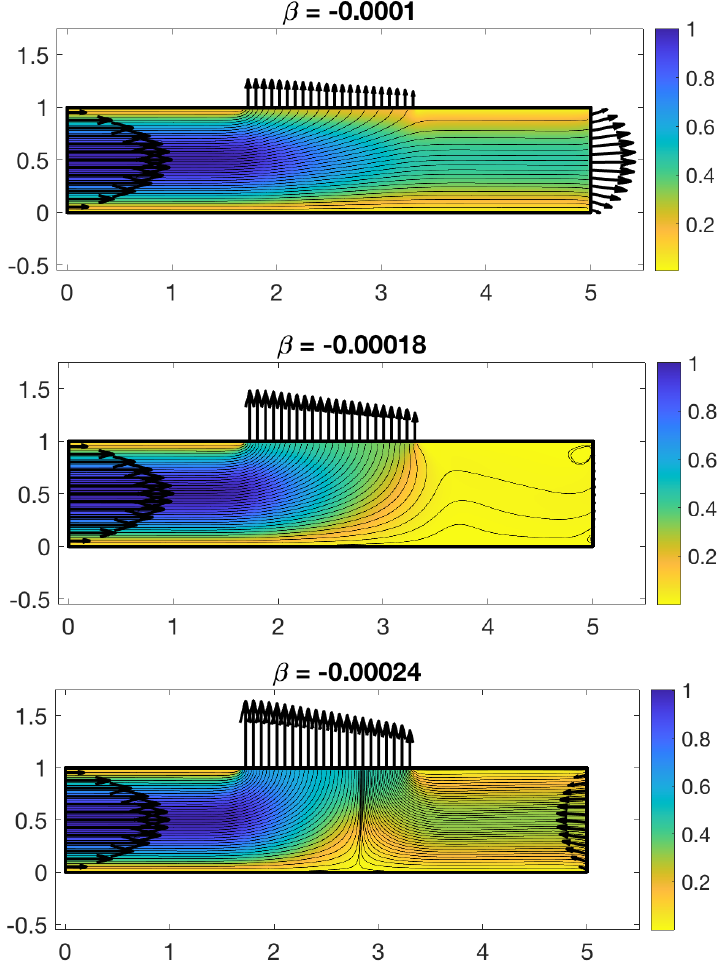
Figure 8. Computed velocity boundary conditions (arrows) and velocity field streamlines for different values of β . The colors represent the magnitude of the velocity in the channel. The numerical parameters used are h = 1/160 and δ =